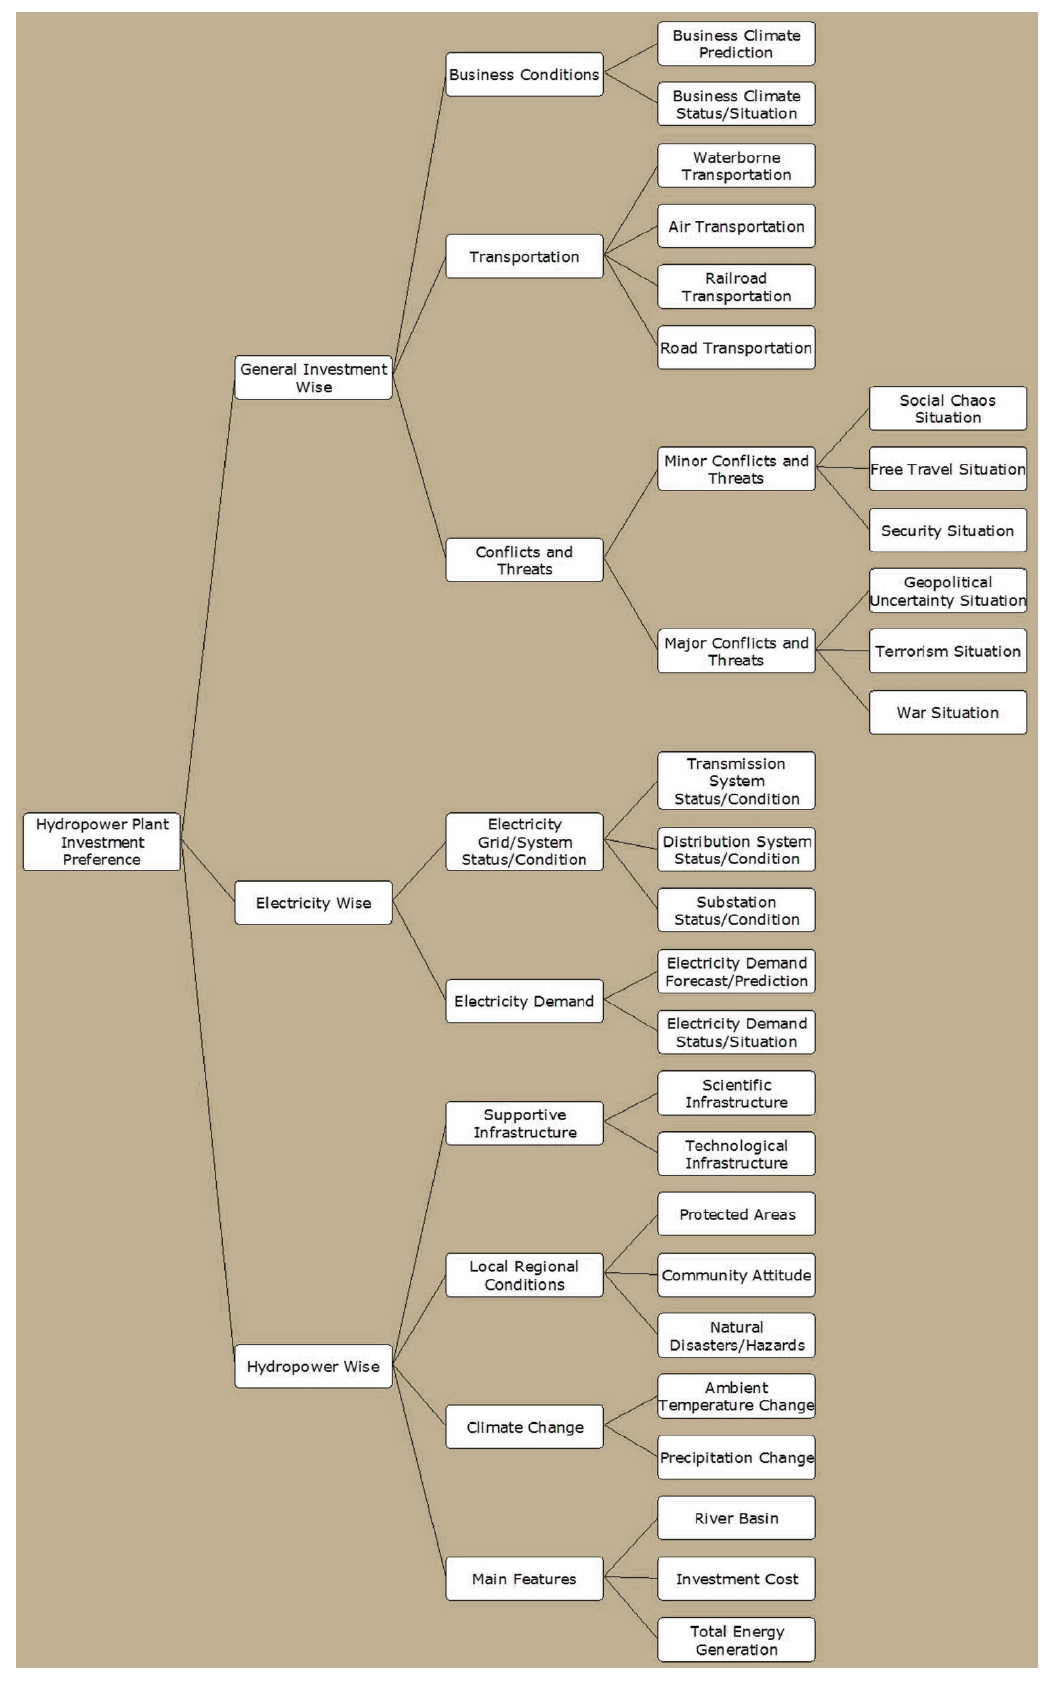
Figure 2. The tree structure view of the current model (DEXiTree)